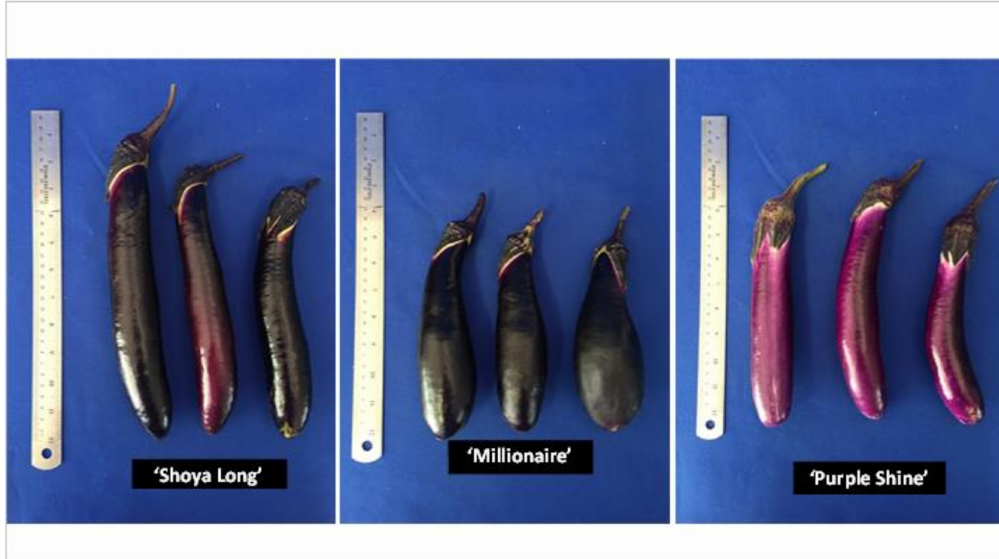
Figure 4. Representative photos of the three Chinese eggplant cultivars (Shoya Long, Millionaire, and Purple Shine) harvested from field plots, 6 weeks after